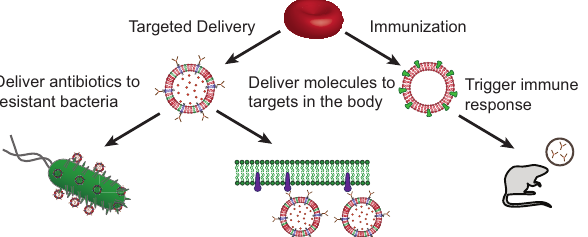
Figure 5. Erythrocyte-based drug delivery platform. ( Left ) Erythrocyte liposomes are produced from red blood cells and their molecular structure and properties tuned by incorporation of synthetic lipids. Specificity is achieved through conjugation of corresponding antibodies to deliver molecules to various targets. For instance, antibiotic resistant bacteria, tumours, or transport proteins in the blood–brain barrier. ( Right ) Virus-like particles can be generated through anchoring of viral antigens in the liposomal membranes to trigger an immune